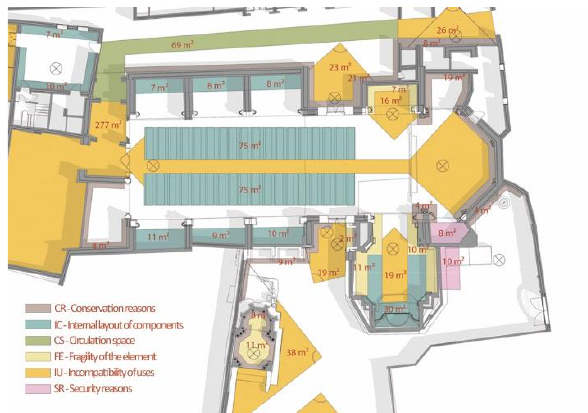
Figure 8. Plan of non-usable surface areas for